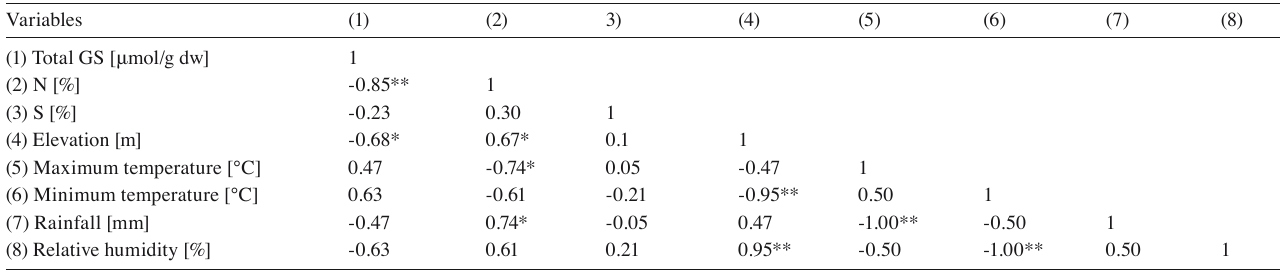
Tab. 6: Spearman’s correlation analysis between the total glucosinolate (GS) content in the leaves of Moringa oleifera and the local conditions of the three agro-ecological zones.